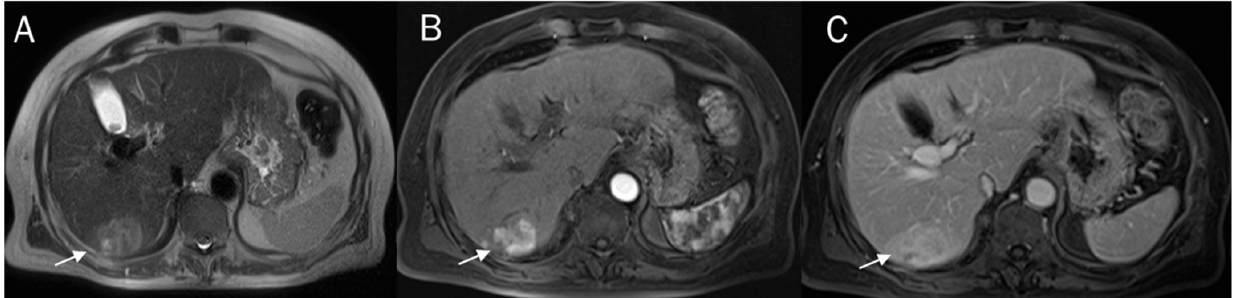
Figure 3. cHCC ‐ CCA on VI hepatic segment. The lesion (arrows) shows hyperintense signal on T2 ‐ W sequences ( A ) and progressive contrast enhancement during the arterial ( B ) and venous ( C ) phases of contrast studies.